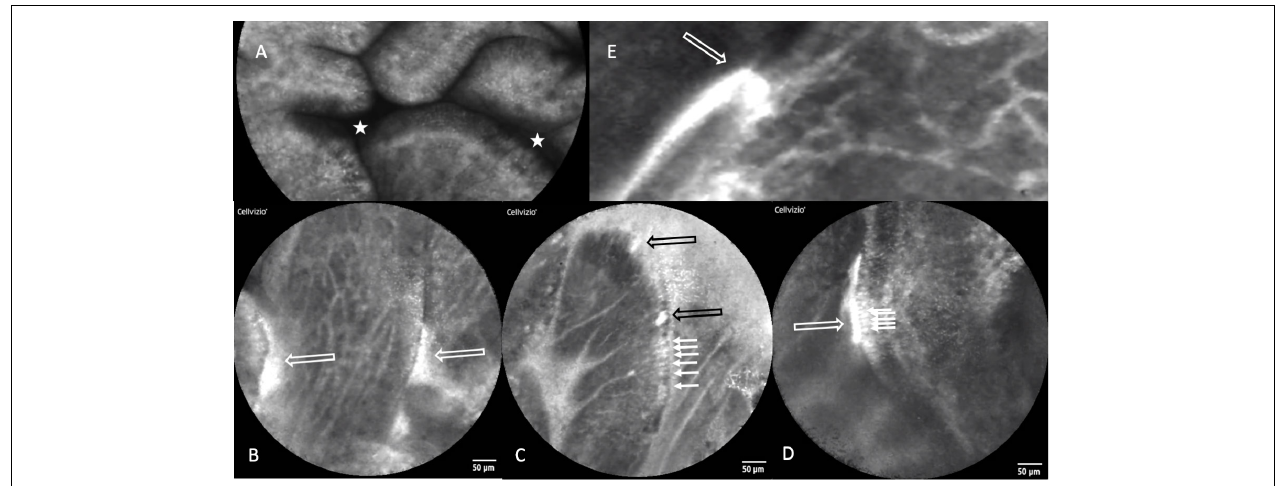
FIGURE 1 | Confocal laser endomicroscopy images of environmental enteropathy in Zambian children with stunting. (A) Normal image showing fluorescein, which was injected intravenously, in villus epithelium and lamina propria and no signal in the lumen which therefore appears dark (star). (B) Fluorescein leakage from epithelium as plumes (white hollow arrows). (C) Fluorescein highlighting intercellular spaces (small arrows) and two microerosions (black hollow arrows). (D) Fluorescein highlighting intercellular spaces and leaking into gut lumen (small arrows). (E) Fluorescein plume (white hollow arrow) originating from capillaries, the escaping through defect in epithelium and into lumen.